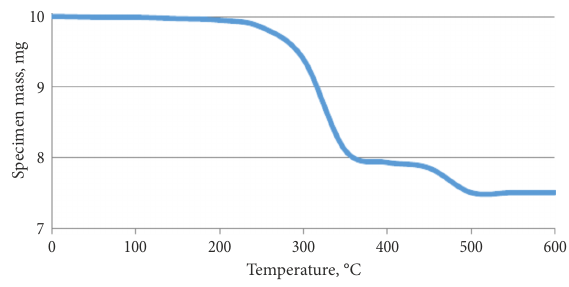
Fig. 2. The mass change of the GFRP while heating at the rate of 5°C per